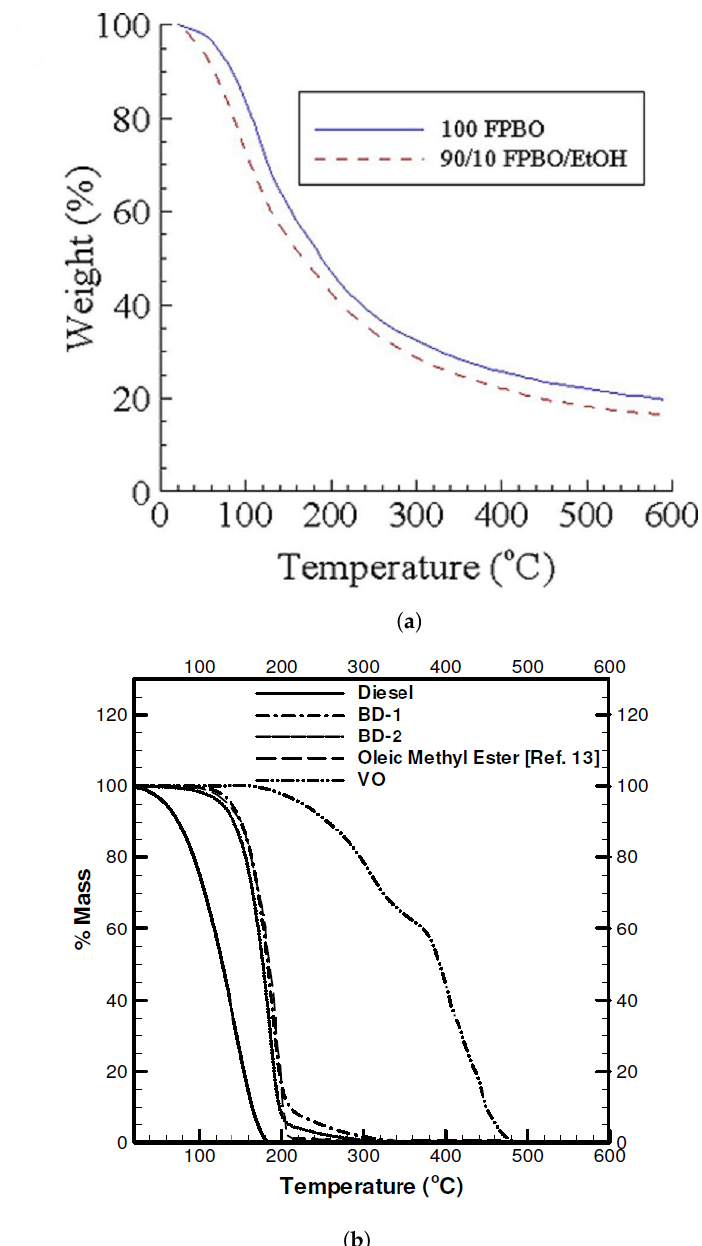
Figure 1. TGA Analysis of Pyrolysis Oils, Diesel and Biodiesel Fuels. ( a ) TGA Analysis of Pyrolysis oils [2]. ( b ) TGA Analysis of Diesel and Biodiesel